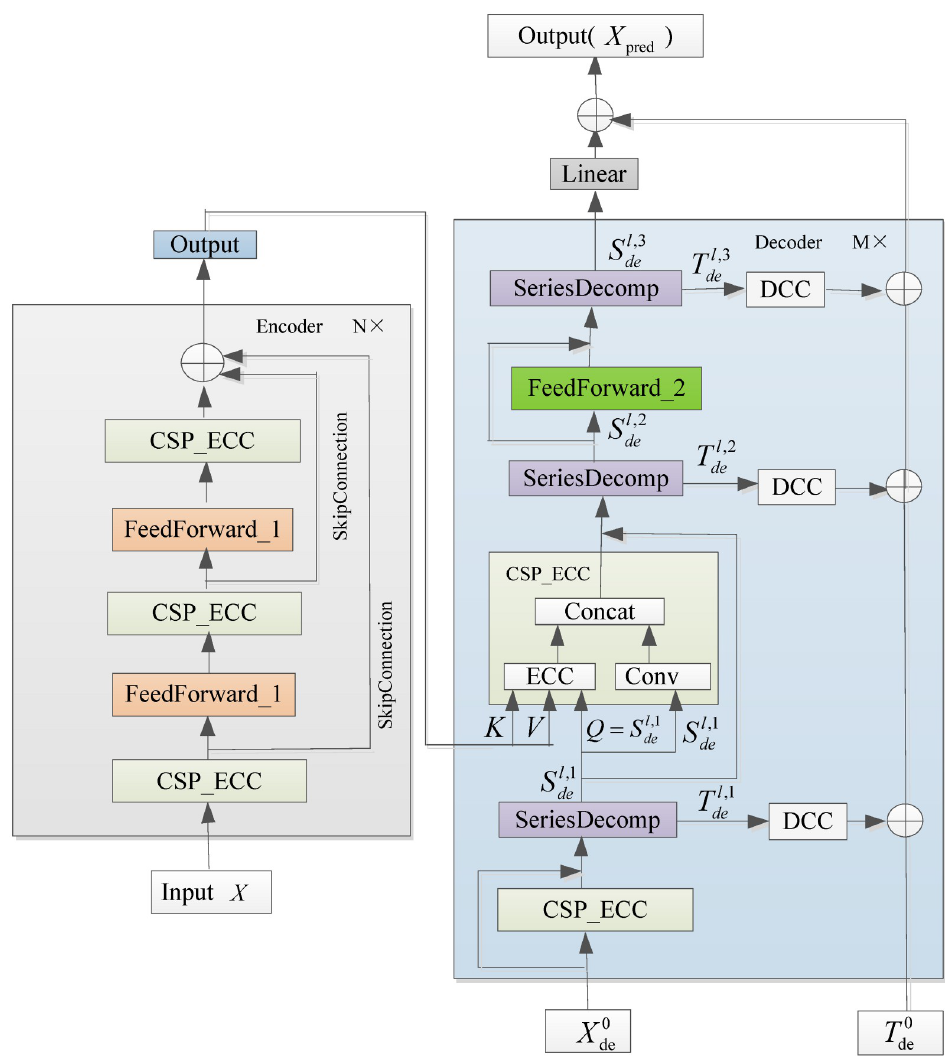
Fig 4. The overall architecture of the EnAutoformer for AQI prediction.